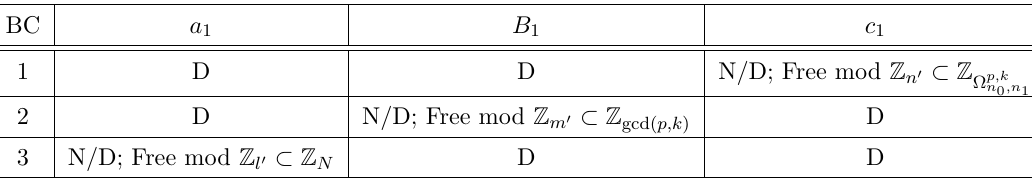
Table 1 . A selection of the possible boundary conditions consistent with the BF-action (6.18), where D: Dirichlet and N: Neumann. We take Ω p,k = nn 0 , gcd ( p, k ) = mm 0 and N = ll 0 . ‘ N/D ; n 0 ,n 1 Free mod Z ’ for a field A means that the field is free to fluctuate modulo the relation qA = 0 . q